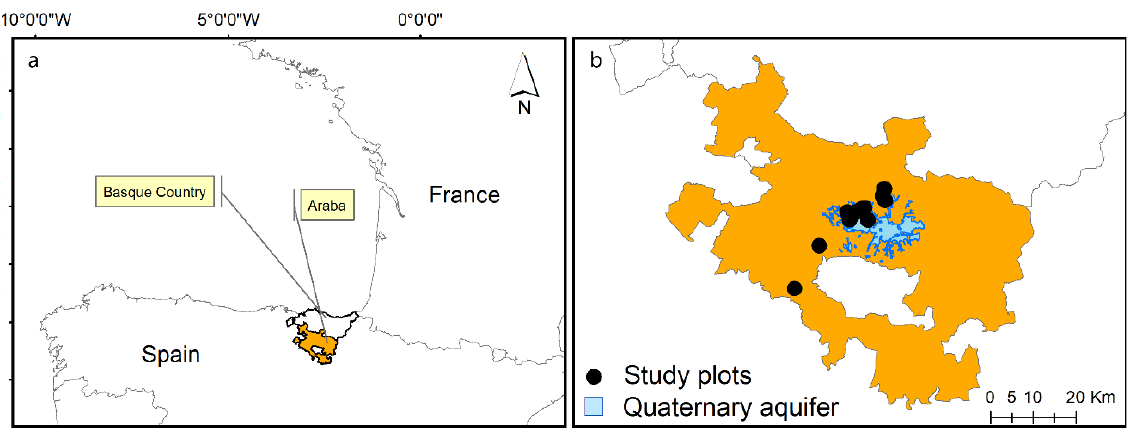
Figure 1. ( a ) Location of Araba/Álava province in Spain, ( b ) Geolocation of the 13 study plots in both regions, “Valles Occidentales” and “Llanada Alavesa”.